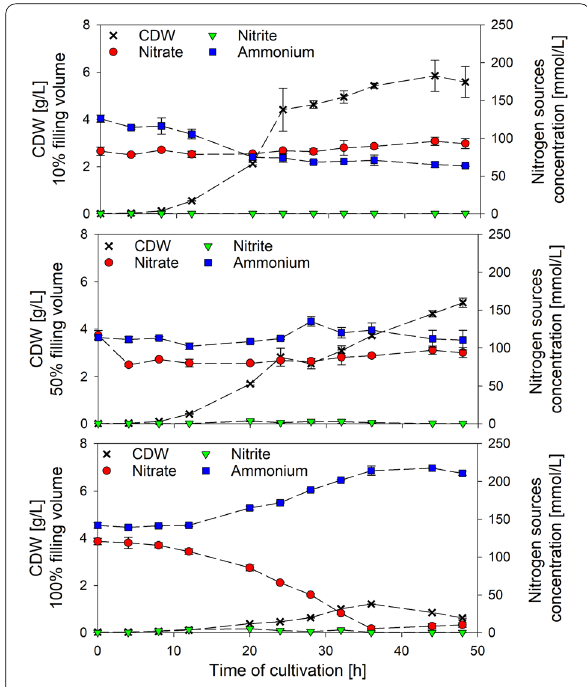
Fig. 1 Cell dry weight (CDW) (g/L) and concentrations of nitrate, nitrite and ammonium (all [mmol/L]) of strain B. subtilis JABs24 cultivated in a mineral salt medium employing 40 g/L